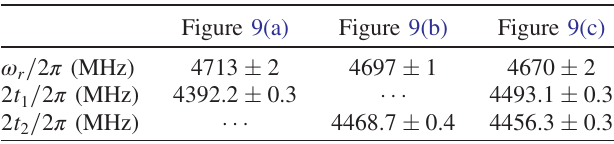
TABLE V. Parameters extracted from the fits performed in Fig. 9 with the coupling rate obtained from fits of the data in Fig. 2.